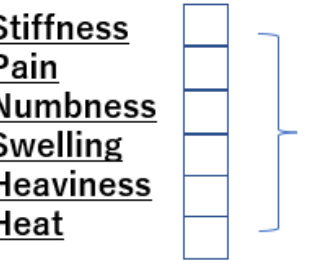
Figure 6. Evaluation sheet of lower leg discomfort. The eleven point rating scale used in the field study to measure the perception of discomfort in the leg. Six items of discomfort on the inspection sheet.